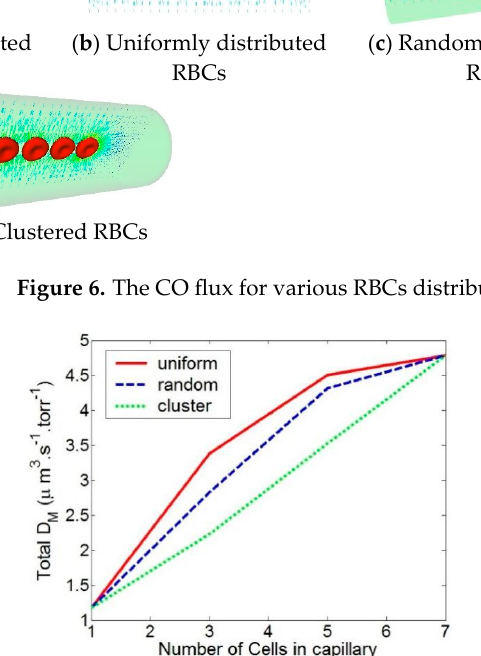
Figure 7. Total diffusion capacity for different RBC distribution and Hematocrit.